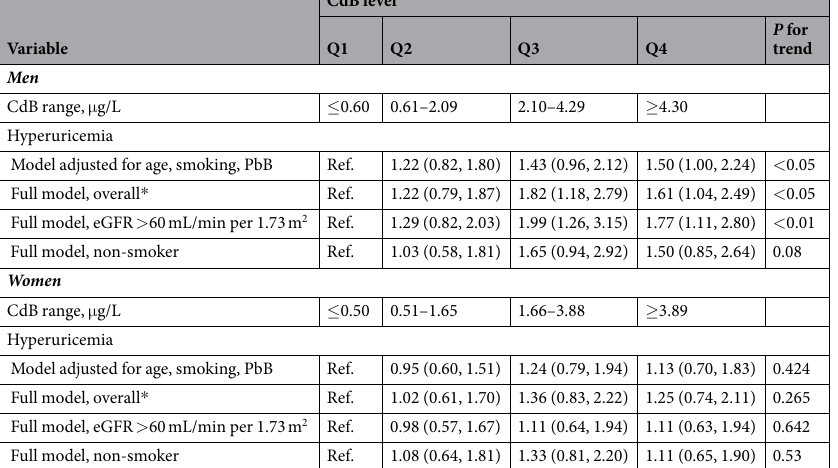
Table 3. Association of blood cadmium level quartiles with hyperuricemia. Data are expressed as odds ratios (confidence interval). Logistic regression analyses were used. eGFR, estimated glomerular filtration rate. * Full model included eGFR (which incorporates age and serum creatinine level), current smoking status, PbB, diabetes, dyslipidemia, hypertension and BMI. All variables were categorical except eGFR, PbB and BMI, which were entered as continuous